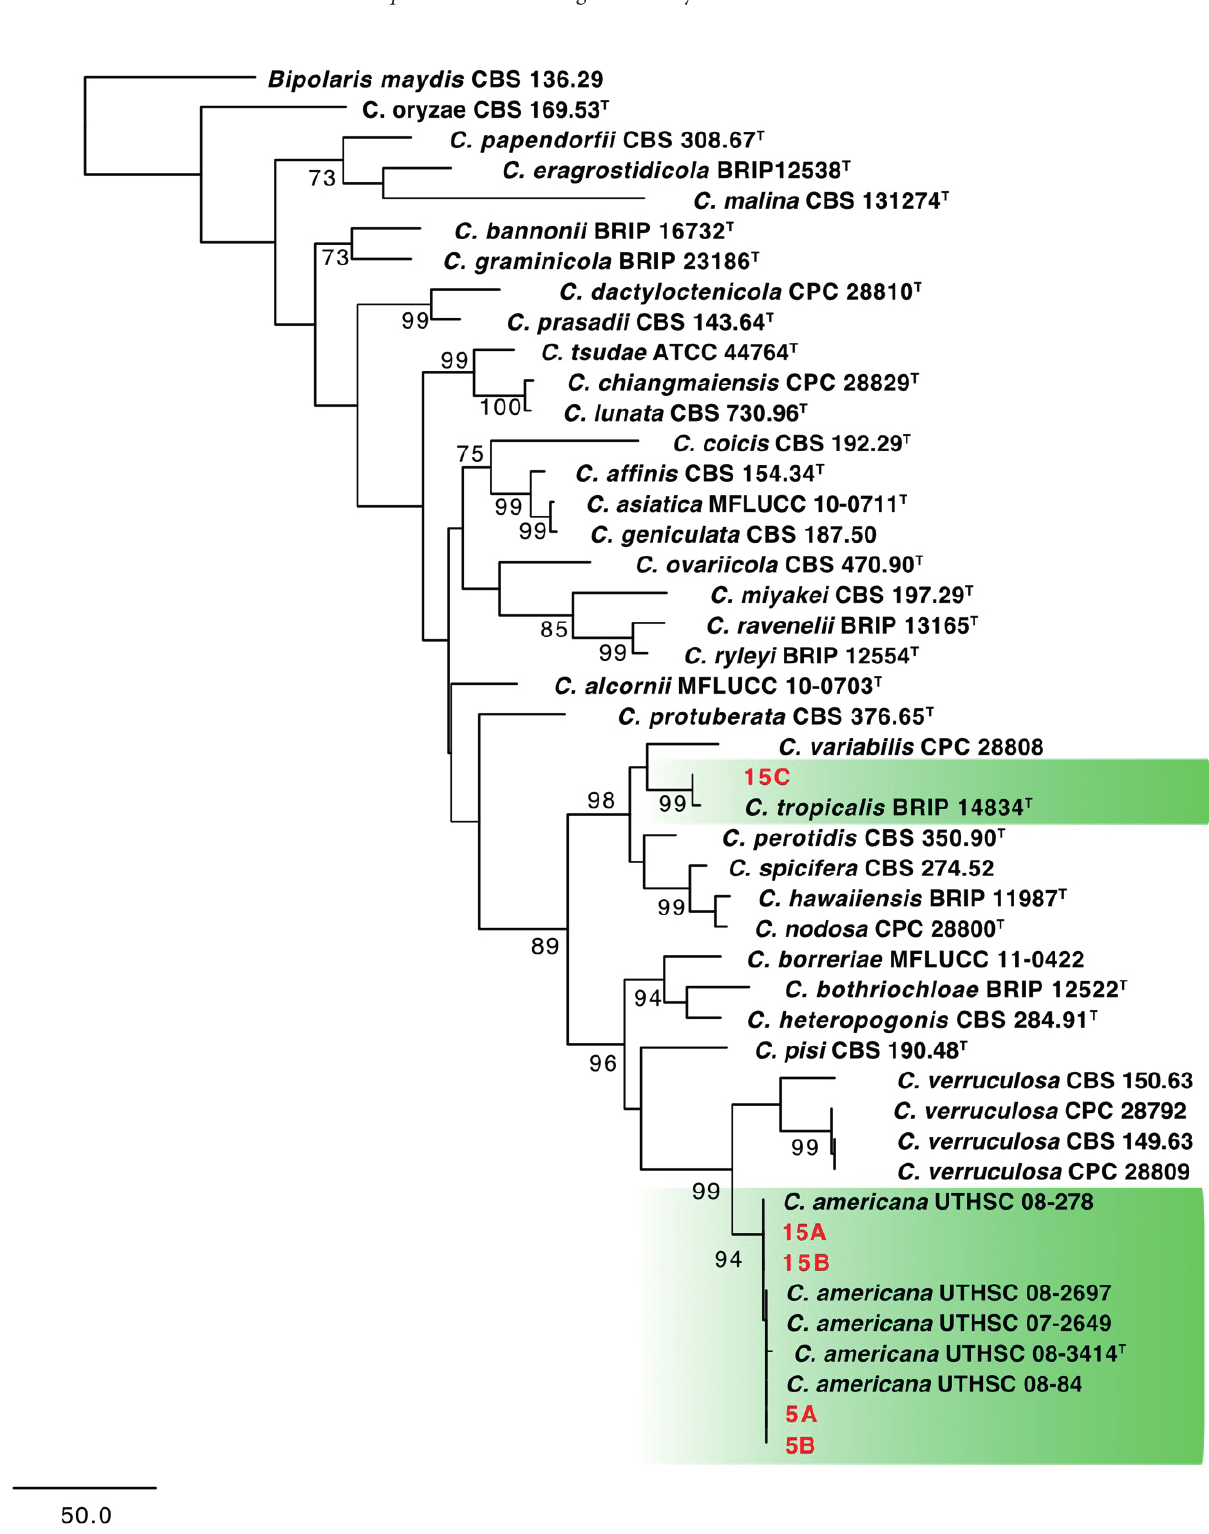
Figure 2. The first of 1000 Equally most parsimonious trees obtained from a heuristic search of the combined ITS, gapdh and tef1-α sequence alignments of Curvularia spp. Bootstrap support values are shown at the nodes. The strains isolated in the present study are shown in red font, and the scale bar represents number of changes. The tree was rooted to Bipolaris maydis (CBS 136.29). T indicates ex- type